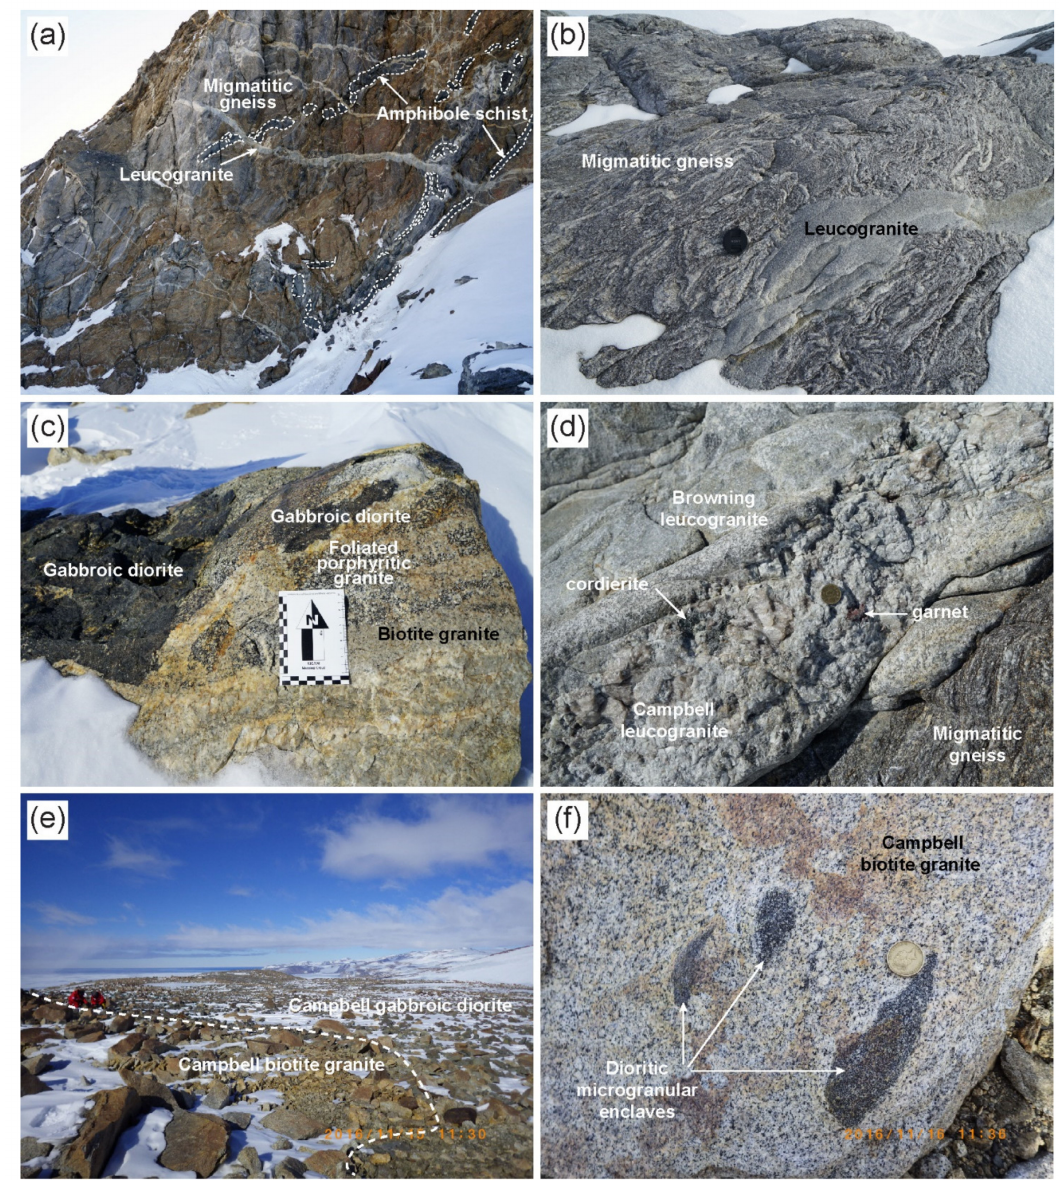
Figure 3. Outcrop photographs showing ( a ) migmatitic gneisses and amphibole schists intruded by leucogranites at a high angle to the foliation, ( b ) migmatitic gneisses intruded by leucogranites, ( c ) the Campbell gabbroic diorites and biotite granites crosscutting the Browning foliated porphyritic granites, and ( d ) two leucogranites types (Browning two-mica leucogranite and Campbell K-feldspar megacryst leucogranite) which intruded migmatitic gneisses. ( e ) The inferred boundary between biotite granites and gabbroic diorites in the CIU near the 3rd Peak. The biotite granites are recognized through the presence of large and light-colored blocks in the field. ( f ) The Campbell biotite granites hosting dioritic microgranular